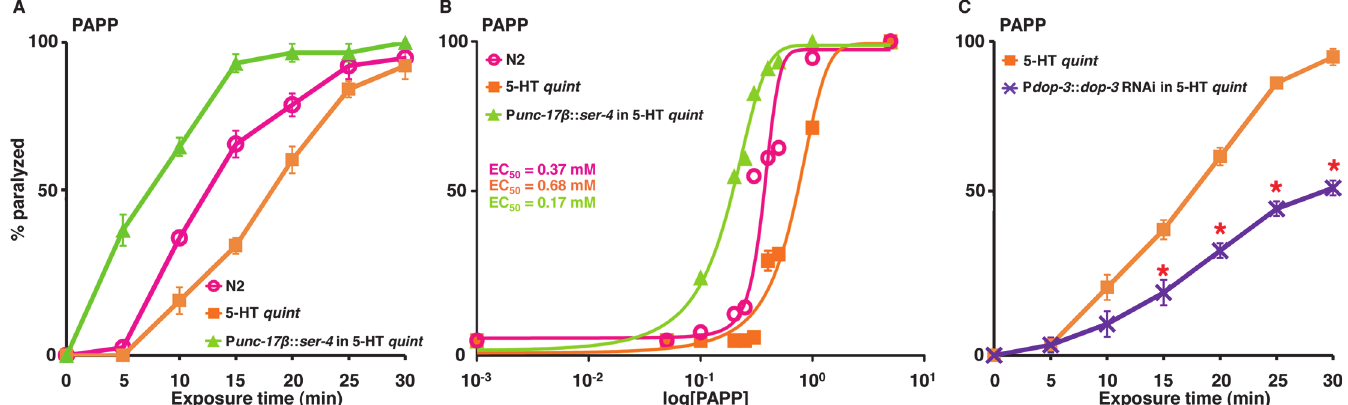
Fig 4. PAPP paralyzes C . elegans via SER-4 and DOP-3. A-C. Paralysis of wild type, mutant and transgenic C . elegans on hypotonic non-NGM agar plates. A. PAPP (0.5 mM)-dependent paralysis of wild-type, 5-HT quint and 5-HT quint animals expressing SER-4 in the cholinergic motor neurons (P unc- 17 β ). Data are presented as mean ± SE (n = 3). B. Dose-response curves for PAPP-dependent paralysis at 15 min exposure for wild type, 5-HT quint and 5-HT quint animals expressing SER-4 in the cholinergic motor neurons (P unc-17 β ). C. PAPP (0.5 mM)-dependent paralysis of 5-HT quint and 5-HT quint animals expressing P dop-3 :: dop-3 RNAi. Data are presented as mean ± SE (n = 3). ‘ * ’ p (cid:3) 0.001, significantly different from 5-HT quint animals assayed under identical conditions.